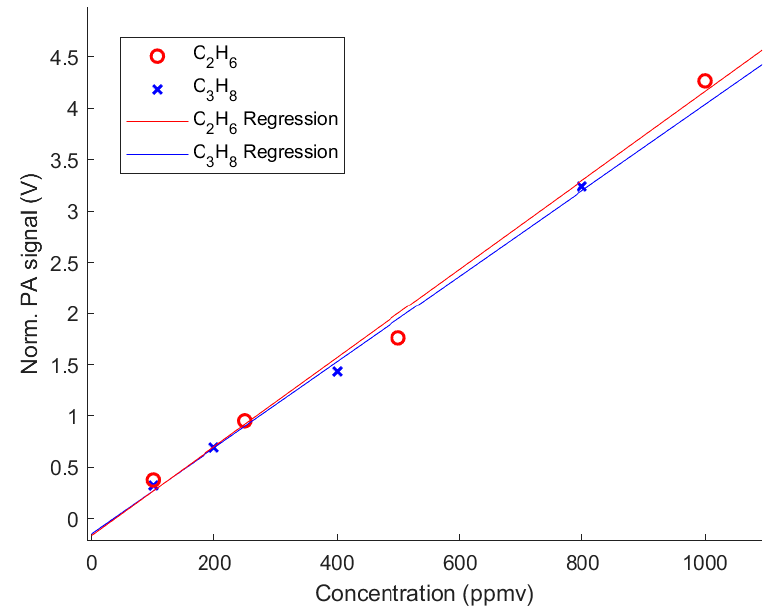
Figure 3. Linearity of the normalized PA signal (integrated over the whole spectrum) obtained of individual C 2 H 6 and C 3 H 8 measurements at different concentrations.